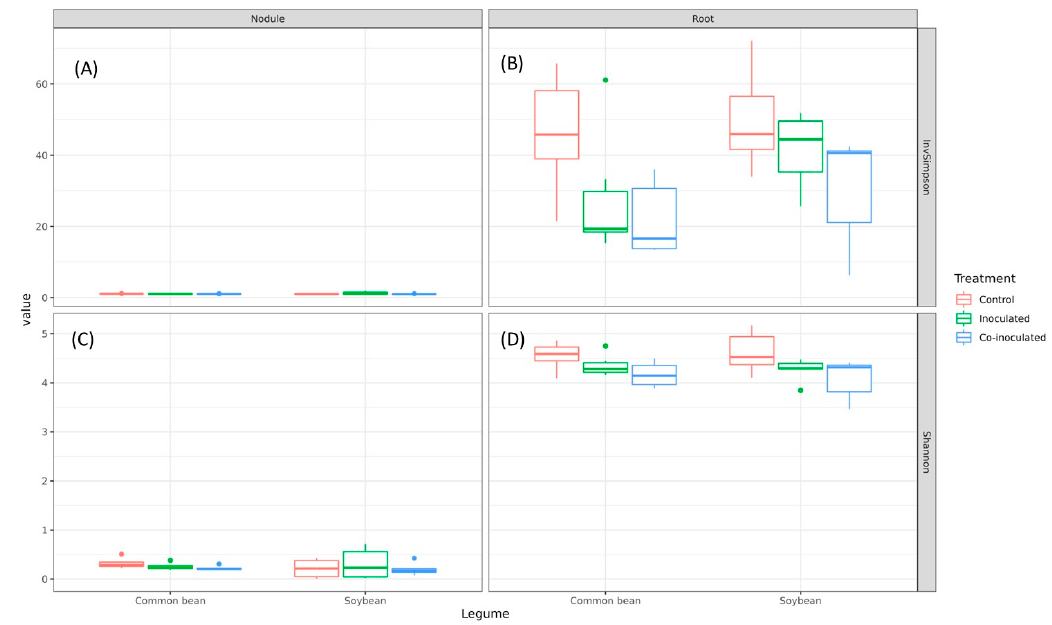
Figure 7. Bacterial Inverted Simpson indexes in the microbiomes of common bean and soybean nodules ( A ) and roots ( B ) and Shannon indexes in nodules ( C ) and roots ( D ) of plants inoculated with specific rhizobia and co-inoculated with rhizobia and Azospirillum brasilense. Consistent with the more drastic reduction in alpha diversity with inoculation in common bean roots, beta diversity indicated that microbiomes of common bean roots were more affected by inoculation than those of soybean (Figure 8). The composition of the soybean root microbiome was not significantly affected by the inoculation and remained more diverse, as shown by alpha diversity (Figure 8A). Meanwhile, treatments significantly changed the composition and reduced the alpha diversity of the common bean root ´ s microbiome (Figure 8C). Int. J. Mol. Sci. 2022 , 23 , x FOR PEER REVIEW